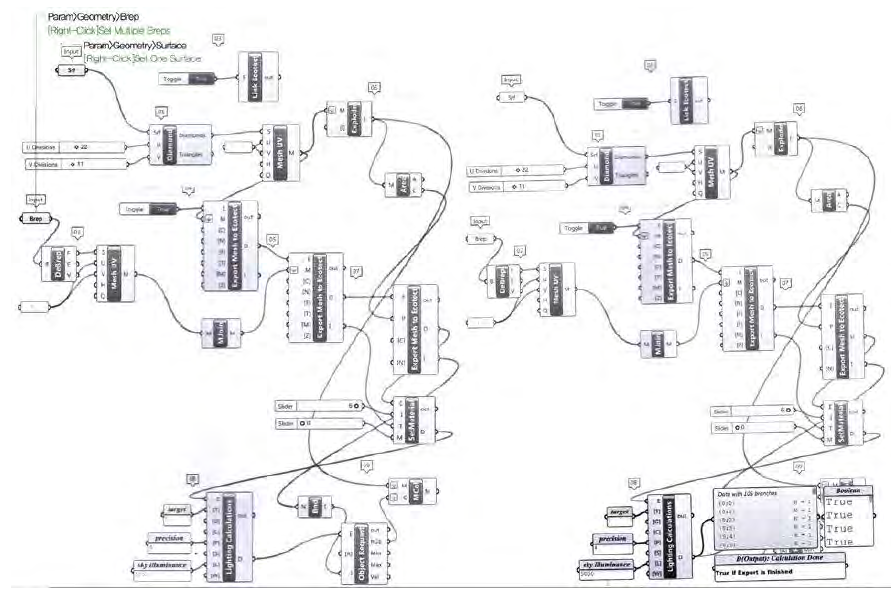
Figure 5. Overall Thermal Transfer Value (OTTV) after application of the module.